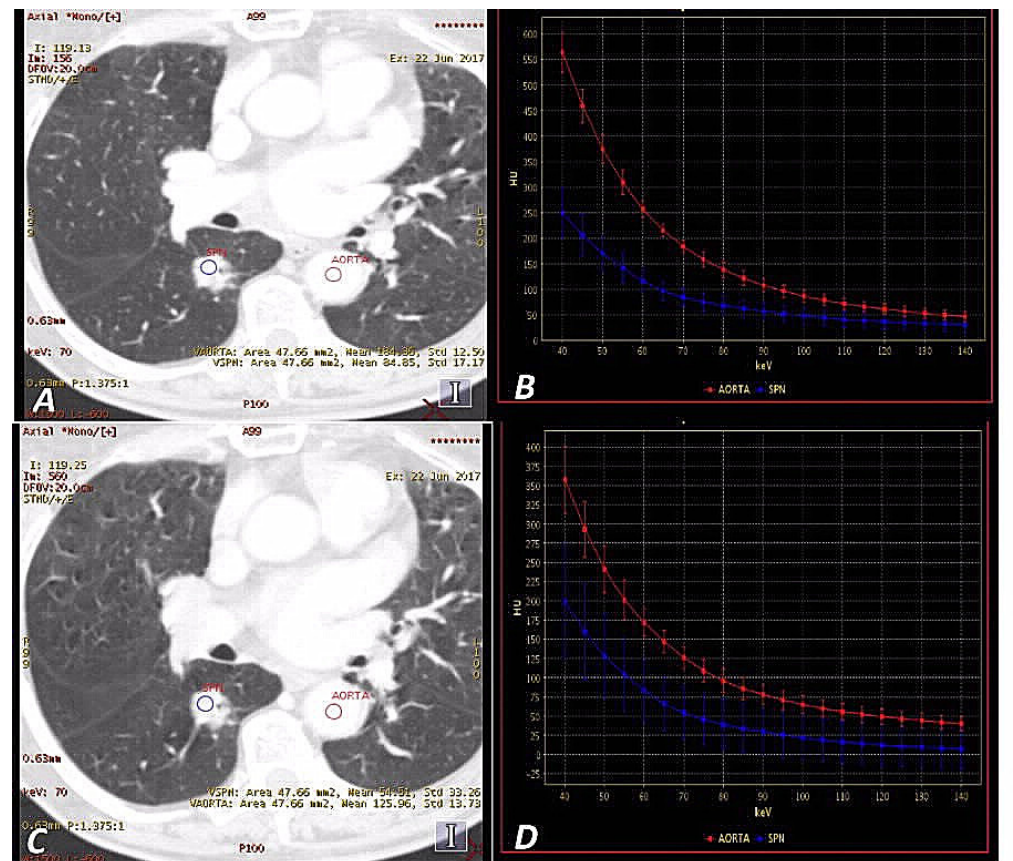
Figure 2. A 65-year-old woman with adenocarcinoma in AP (late-arterial phase) ( A , B ) and VP (venous phase) ( C , D ). Monochromatic 70 keV SS DECT (single source Dual Energy Computed Tomography) images show a hyperattenuating solitary pulmonary nodule(SPN) in the right lung (blue regions of interest (ROI)) ( A , C ). The graphs show DECT spectral attenuation curves for the enhancing mass SPN (blue) and descending aorta (red) ( B , D ). An increasing curve slope is visible at lower energies, which is related to the interaction of iodine atoms with photons at these energy levels based on the photoelectric effect. Attenuation of SPN mean: (AP) = 84.85 HU, (VP) = 54.51 HU.